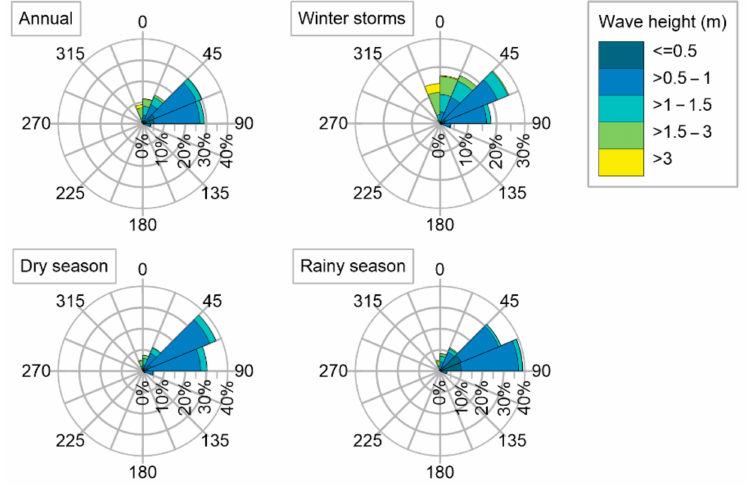
Figure 5. Annual and seasonal wave roses for La Mancha, data from Era5 [23]. Storms, Tropical Cyclones and Hurricanes